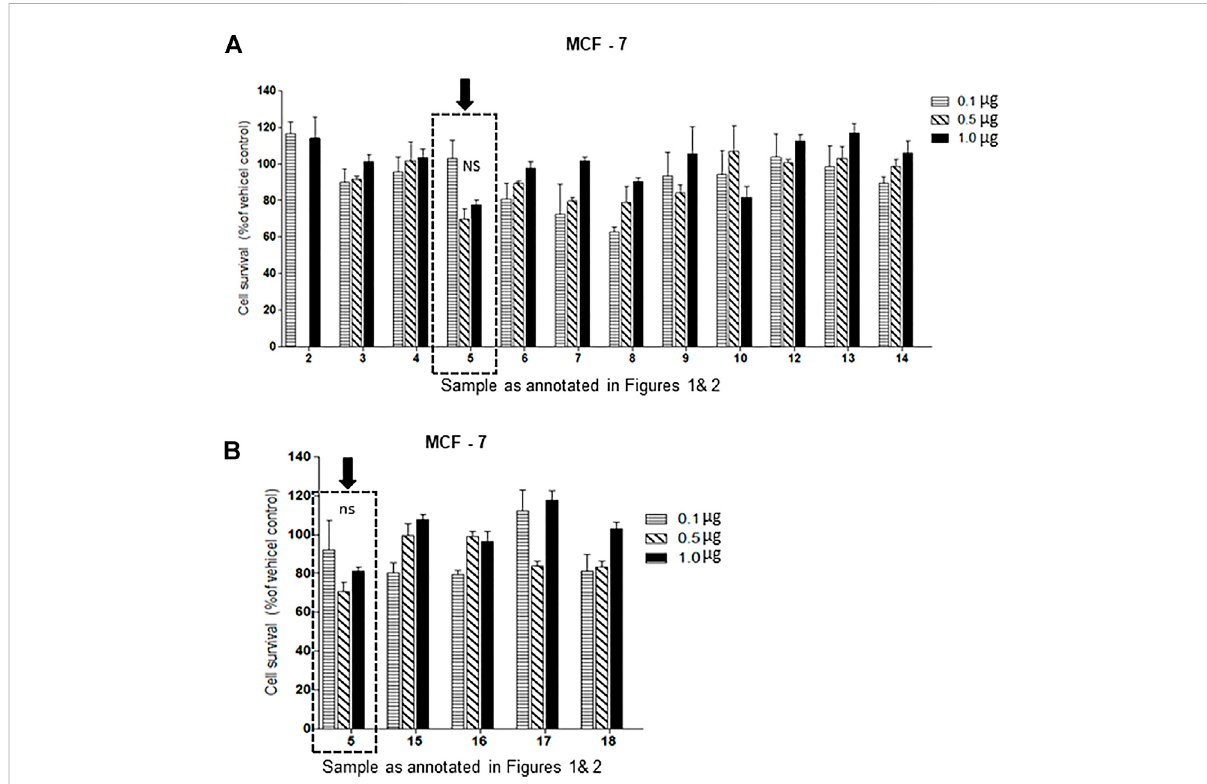
FIGURE 5 (A,B) : Dose-response comparison of the cytotoxic effects of various sterols (as % of ethanol vehicle control) shown to be present in EGS in this study on MCF-7 an estrogen receptor positive breast cell line in vitro ., Interestingly the cell survival data presented as percentage of vehicle control shows that triols #5 and others are weakly (non-signi fi cant) active in MCF-7 cell line ( n = 3, p < 0.05, One-way ANOVA with Dunnett ’ s post-test to compare response of different